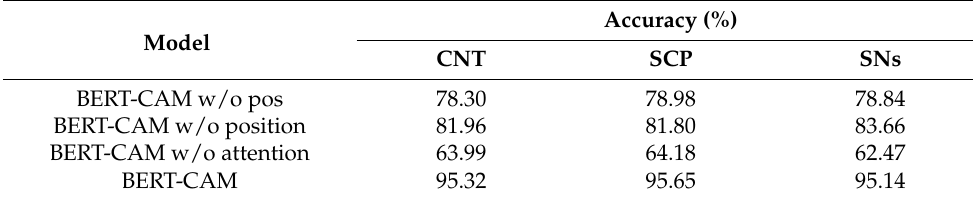
Table 5. TC accuracy of ablation